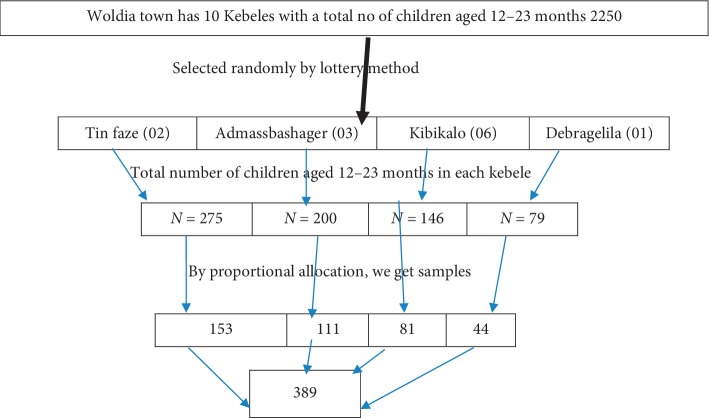
Schematic presentation of the sampling procedure.